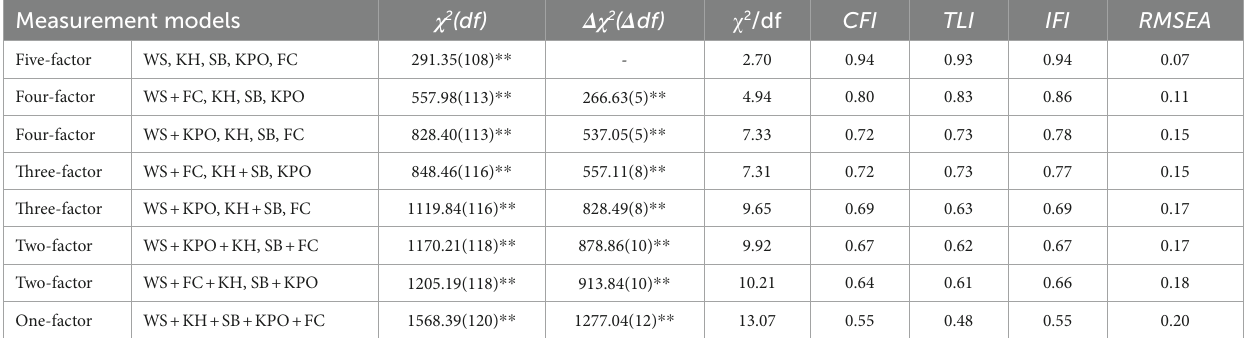
TABLE 1 The results of confirmatory factor analysis. Measurement models